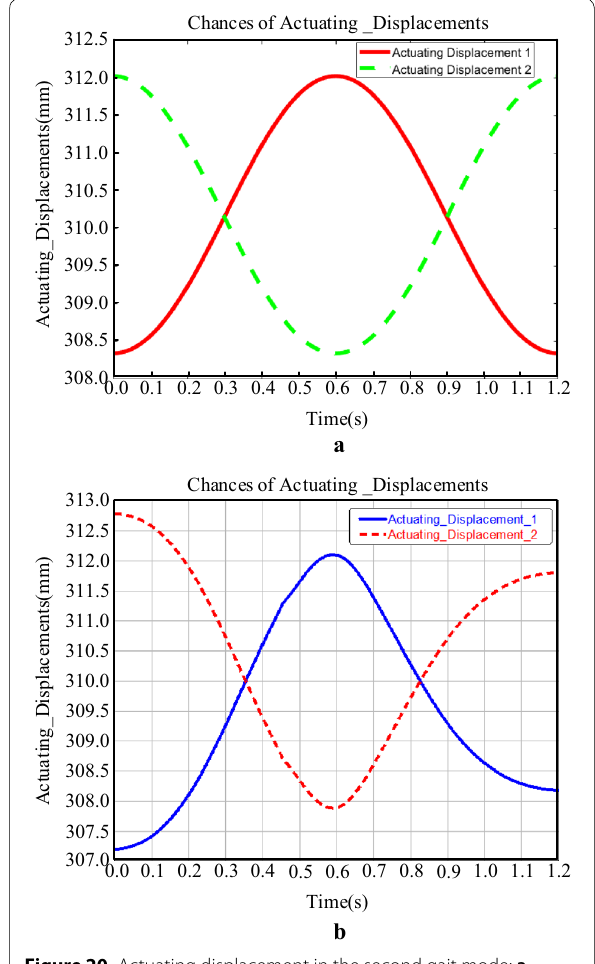
Figure 20 Actuating displacement in the second gait mode: a actuating displacement by Matlab; b actuating displacement by Adams